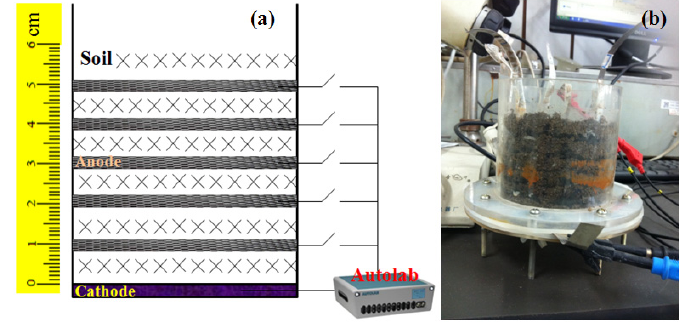
Figure 1. Schematic ( a ) and photograph ( b ) of the resistance measurement design.